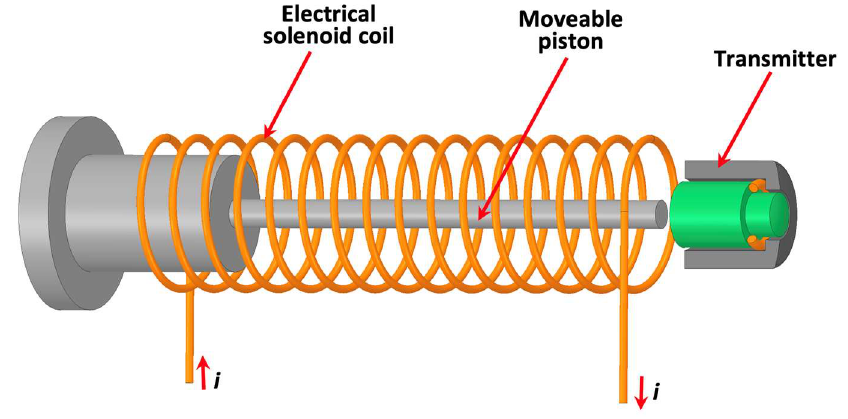
Figure 5. Main part of electromagnetic applicator—solenoid with moveable piston.